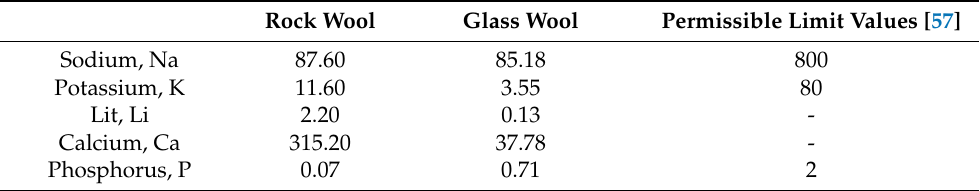
Table 6. Leachability of selected elements (mg/L) from the tested waste. Rock Wool Glass Wool Permissible Limit Values